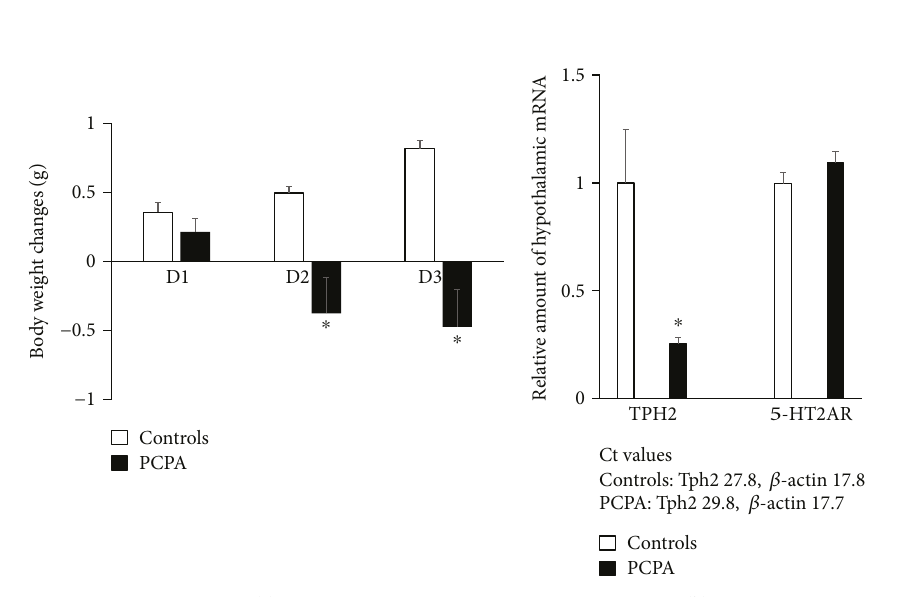
Figure 1: E ff ects of intraperitoneal injection of PCPA (500mg/kg) for 3 days on body weight changes (a) and expression of hypothalamic Tph2 and 5-HT2A receptors (b) in mice. Basal body weight was 22.1 ± 0.2g in controls and 21.8 ± 0.2 g in the PCPA-treated mice. Data are presented as the mean values ± SEM ( n = 6 /group of animals). ∗ P < 0 05